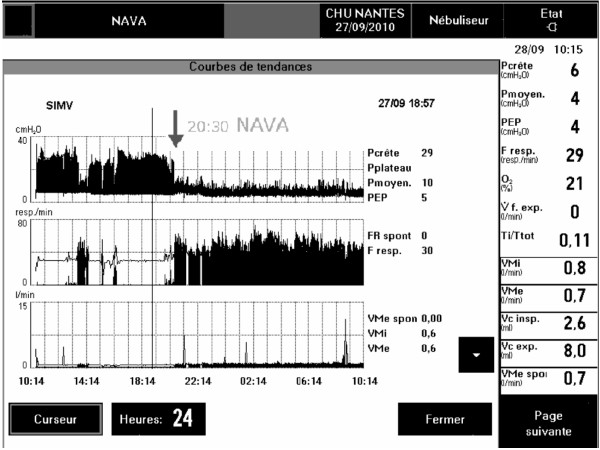
Screenshot with trends over 24 hours (case 1). In the window untitled "Courbes de tendances" (Trend curves), three panels report trends over 24 hours of peak inspiratory pressure (cm H2O), respiratory rate (resp/mn), and minute volume (l/min). On the right of these panels, the values of these ventilatory parameters were collected to the vertical bar (at 18:57 while the child was not receiving NAVA). The downward vertical arrow indicates the switch from SIMV to NAVA (at 20:30). Outside the window untitled "Courbes de tendances", on the right of the scrennshot, ventilatory parameters were collected the next day at 10:15 while the child was receiving NAVA. The upper pannel showed a decrease in peak inspiratory pressure after the switch of ventilation. The middle pannel showed the extreme variability of the respiratory ratein NAVA (the white area under the curve corresponds to the mandatory respiratory rate, while the black area corresponds to the spontaneous respiratory rate). The lower pannel showed minute volume that remained unchanged. When comparing values of ventilatory parameters in SIMV (at 18:57) with those in NAVA (next day at 10:15), peak inspiratory pressure decreased from 29 to 6 cm H2O, mean airway pressure decreased from 10 to 4 cm H2O, spontaneous respiratory rate varied from 0 to 29 breaths/min. Abbreviations: SIMV, synchronized intermittent mandatory ventilation; PEP, positive end-expiratory pressure; P crête, peak inspiratory pressure; P moyen, mean airway pressure; FR spont, spontaneous respiratory rate; F resp, respiratory rate; VM, minute volume; FiO2, fraction of inspired oxygen.